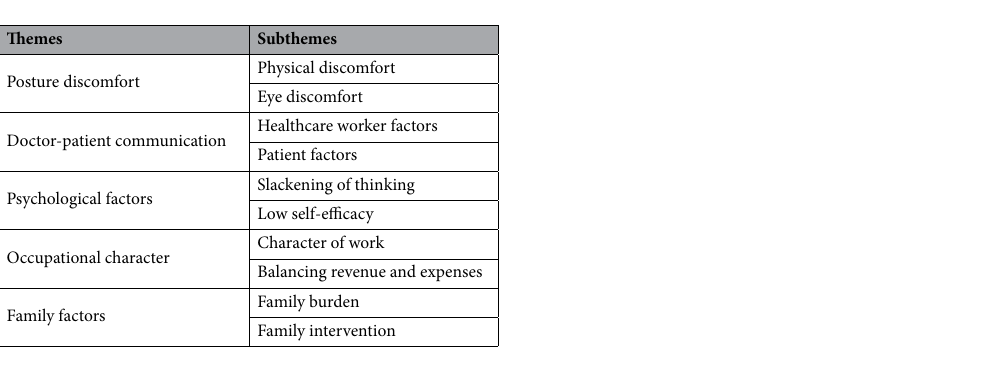
Table 2. Identified themes and